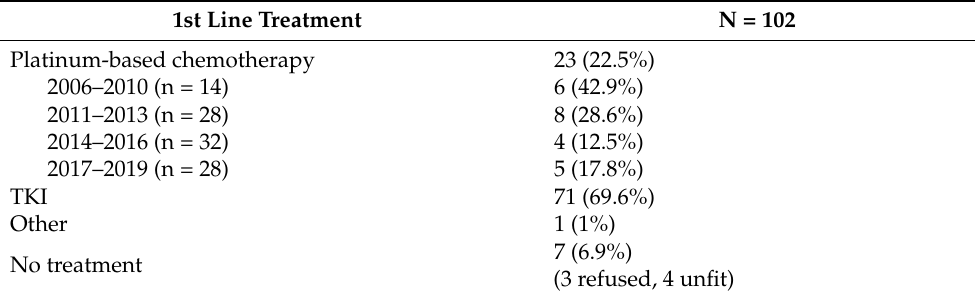
Table 3. 1st line treatment in the overall population.